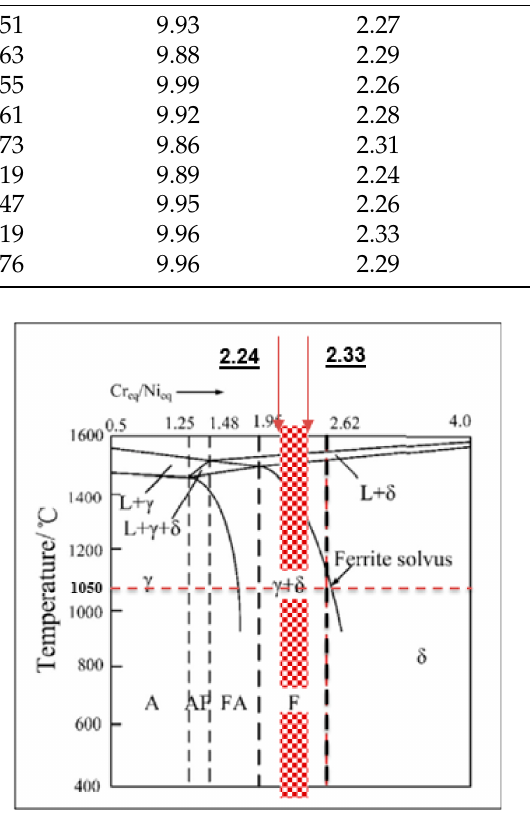
Figure 2. The DSSs solidification modes in the ternary Fe-Cr-Ni